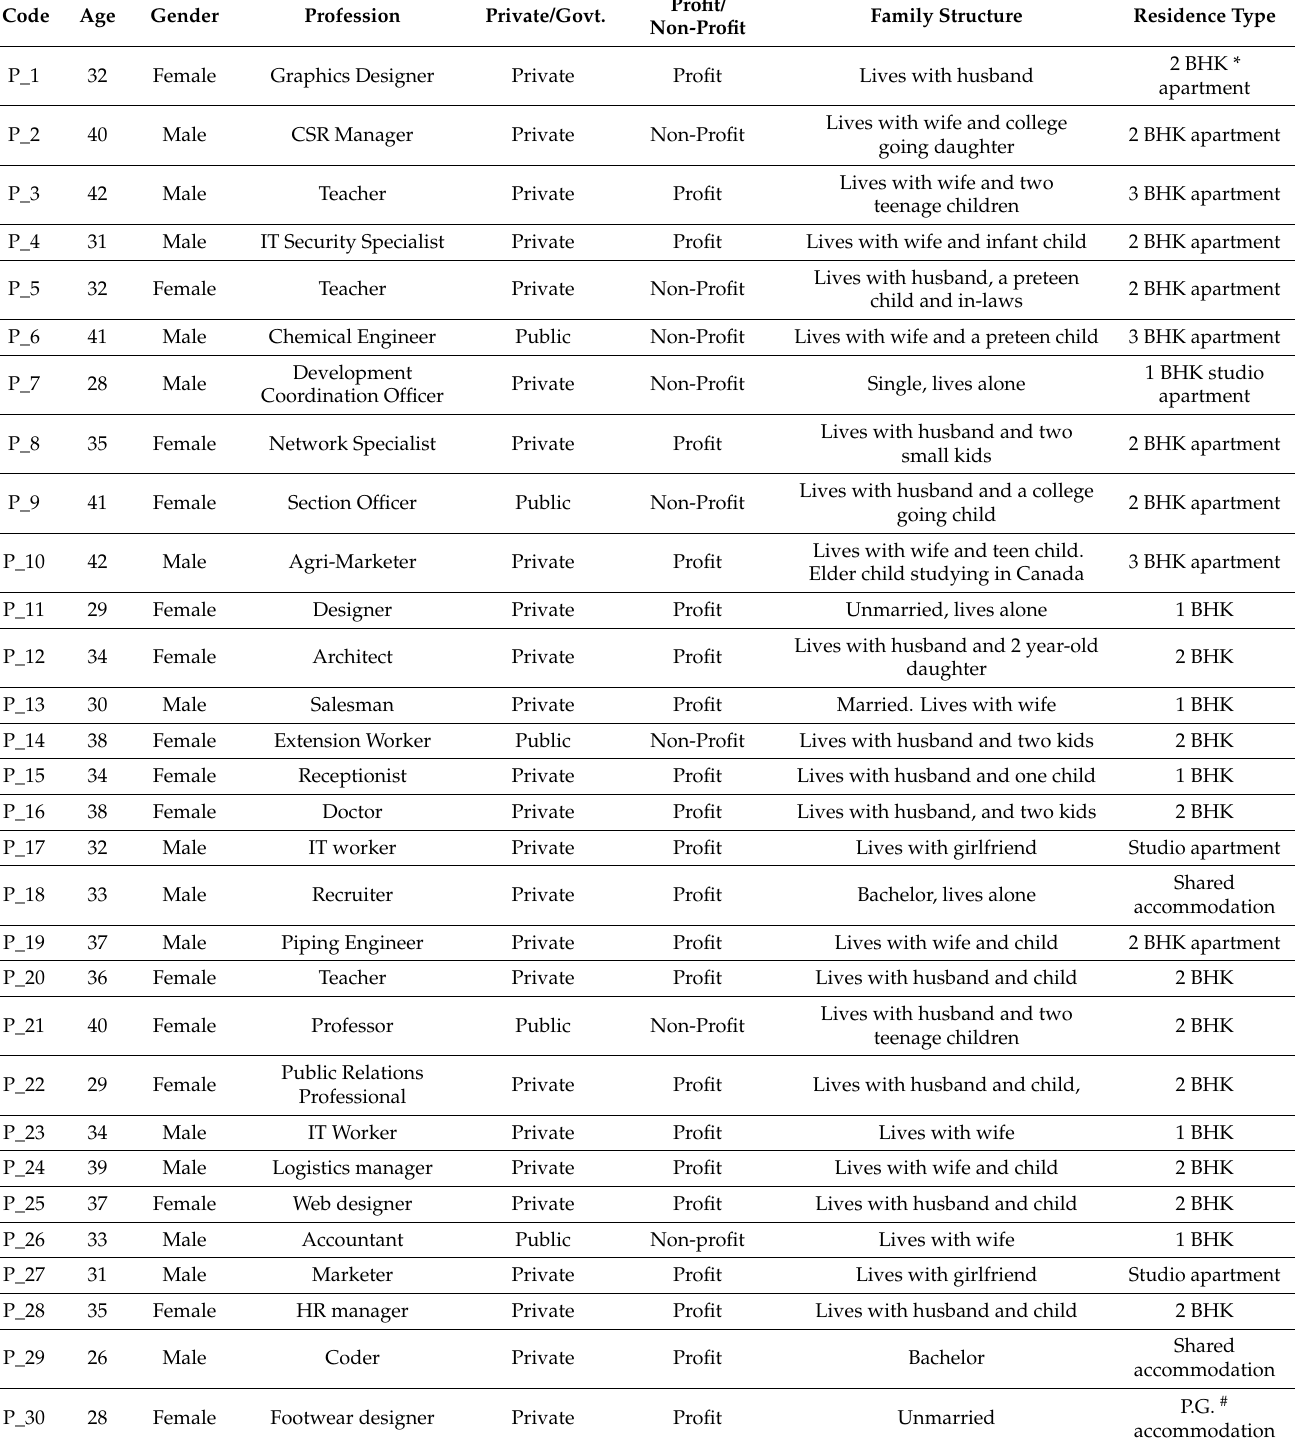
Table 1. Demographic and Background